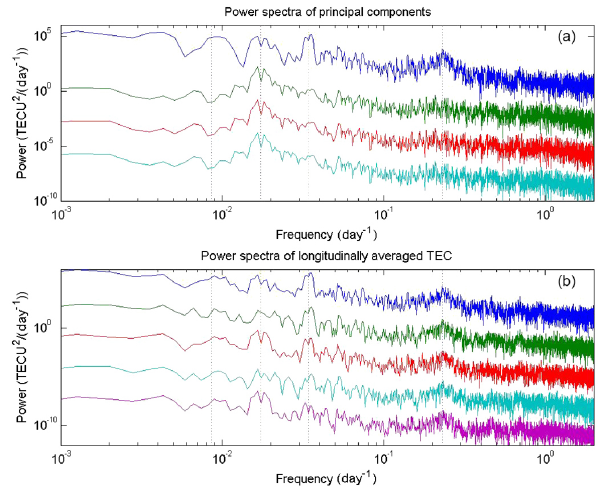
Figure 12. Fourier power spectra of the first four PCs shown in Fig. 9 (panel a ) and the time series at five different latitudes shown in Fig. 10 (panel b ). To avoid clustering, all the curves except the first PC in the upper panel and the one at the Equator in panel (b) have been consecutively shifted downward by 3 orders of magni-